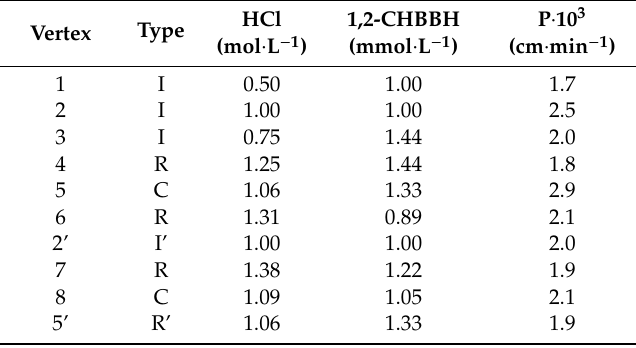
Table 1. Simplex optimization of chemical variables.